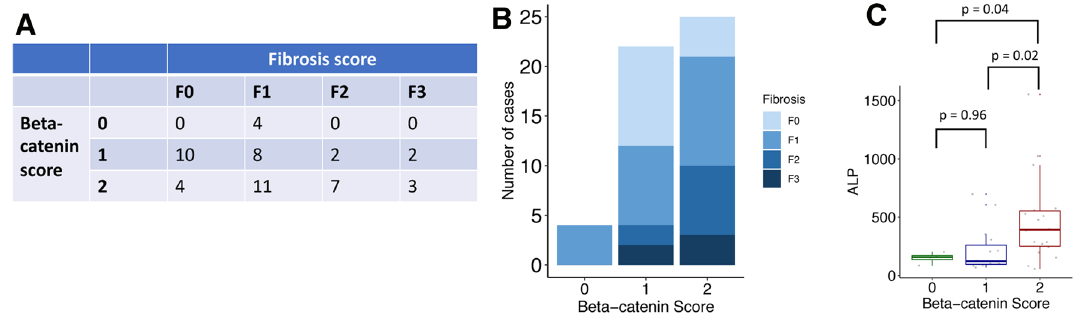
Figure 6. Nuclear β-catenin is associated with a nonsignificant increase in portal fibrosis and higher levels of serum ALP. ( A ) A continency table summarizing the distribution of fibrosis scores across the three categories of β-catenin staining. ( B ) Summarizing the data shows that 45% of samples with membranous β-catenin have no fibrosis, while the majority (84%) of samples with nuclear β-catenin have at least mild fibrosis. p = 0.108 by Fisher’s exact test. ( C ) Box and whisker plot shows a significant association between β-catenin localization and levels of serum